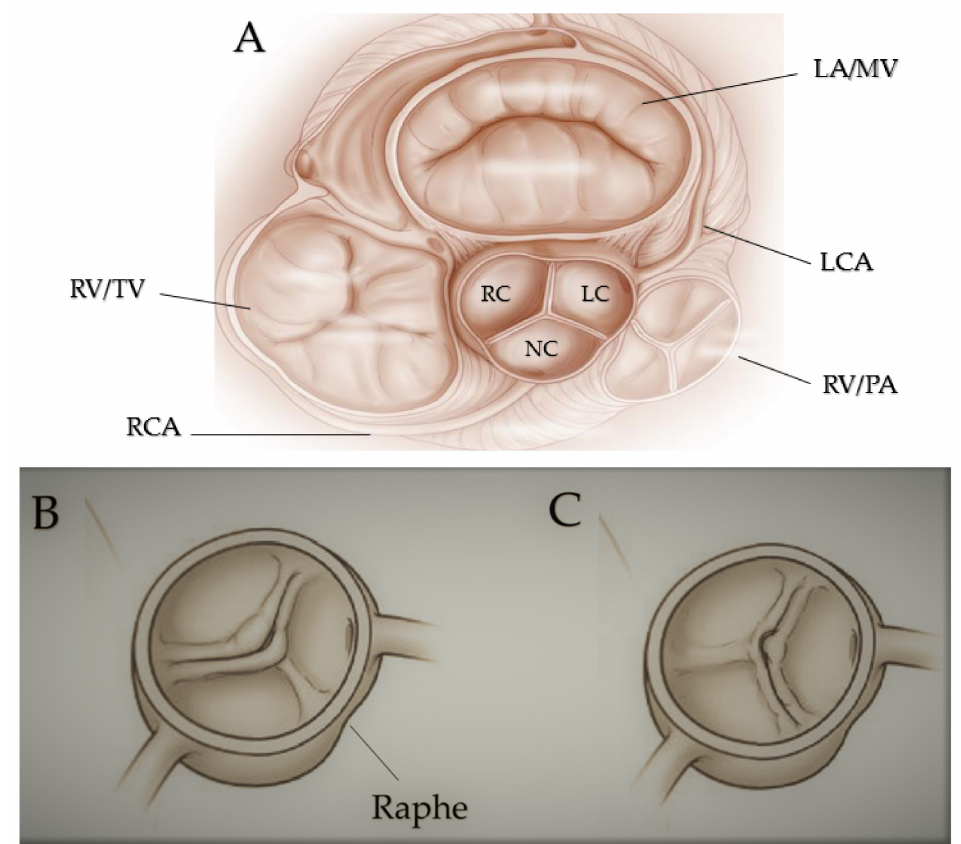
Figure 1. Fused bicuspid aortic valve. ( A ) Represents short-axis normal tricuspidal aortic pattern with anatomical proximities. Cusps’ fusion patterns seen in short heart axis: right-left coronary fusion ( B ), right-non coronary fusion ( C ). All BAVs have three sinuses. Raphe structure is between the fused cusps. Non-fused cusp is prominent in respect to the fused ones. The commissure angle of the non-fused cusp has a degree < 180 ◦ . Abbreviations: LA, left atrium; LC, left cusp; LCA, left coronary artery; MV, mitral valve; NC, non-coronary cusp; PA, pulmonary artery; RA, right atrium; RC, right cusp; RCA, right coronary artery; RV, right ventricule; TV, tricuspidalic valve. Licenses Centre Cardiologique du Nord; order date 8 September 2022; order number 5384080341542; publication NEJM; Title: Mitral valve Repair for Mitral valve